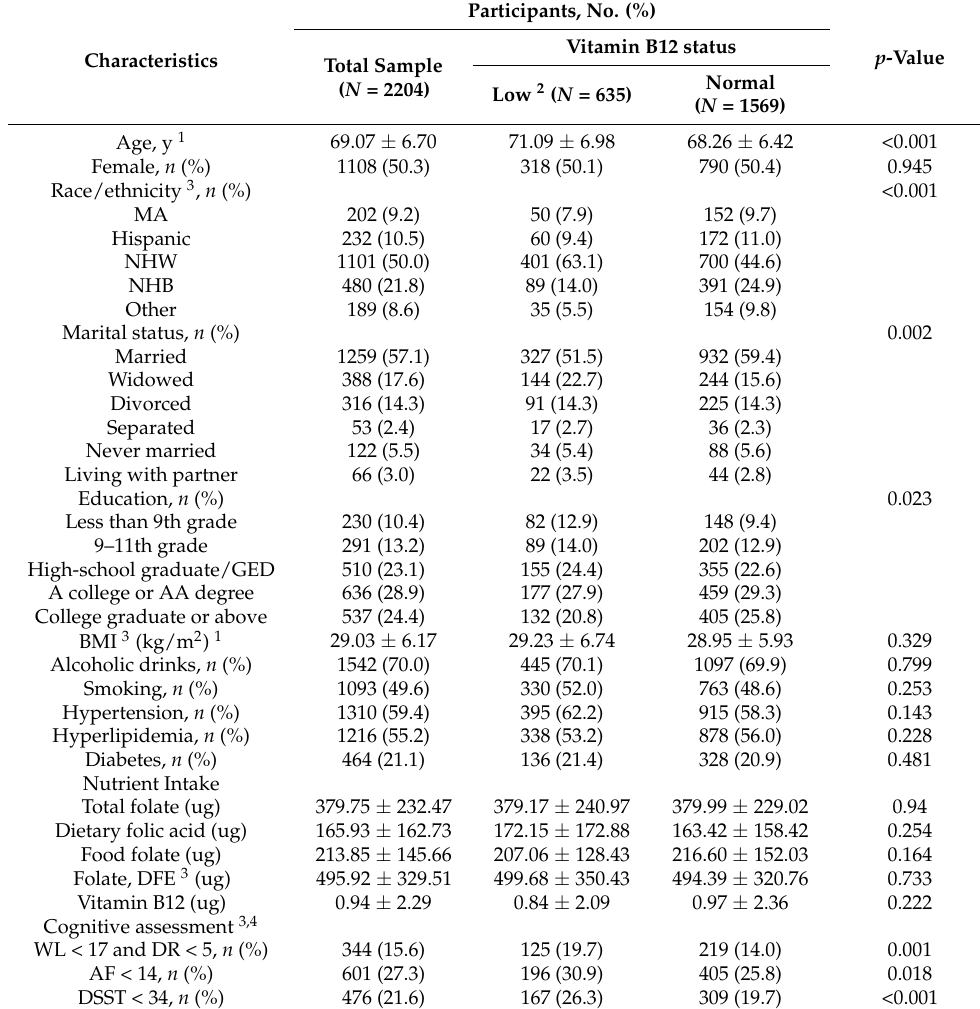
Table 1. Baseline characteristics of the study